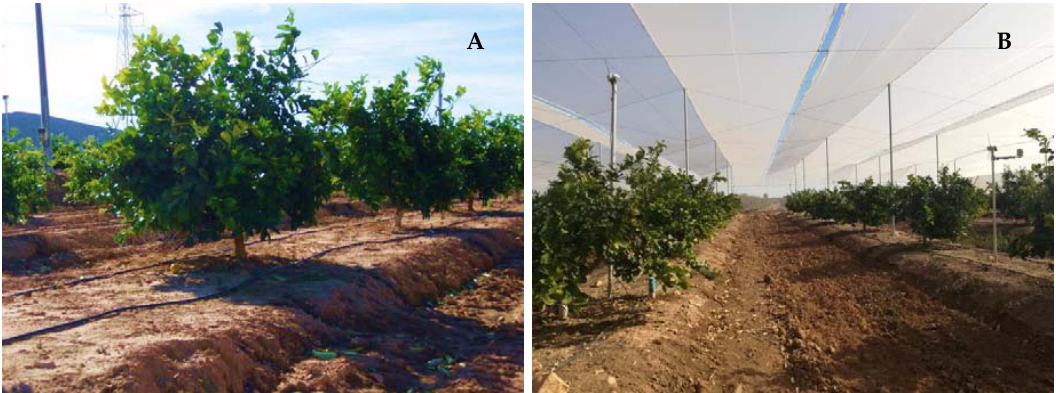
Figure 8. General view of lime trees ( Citrus latifolia Tan., cv. Bearss) grown in open-air ( A ) and shade net house ( B )